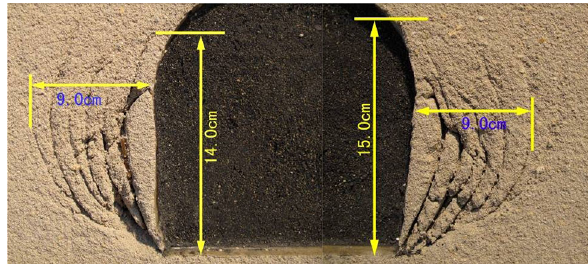
Fig. 8 Width and height of cracks on the left and the right side walls of the M1 model